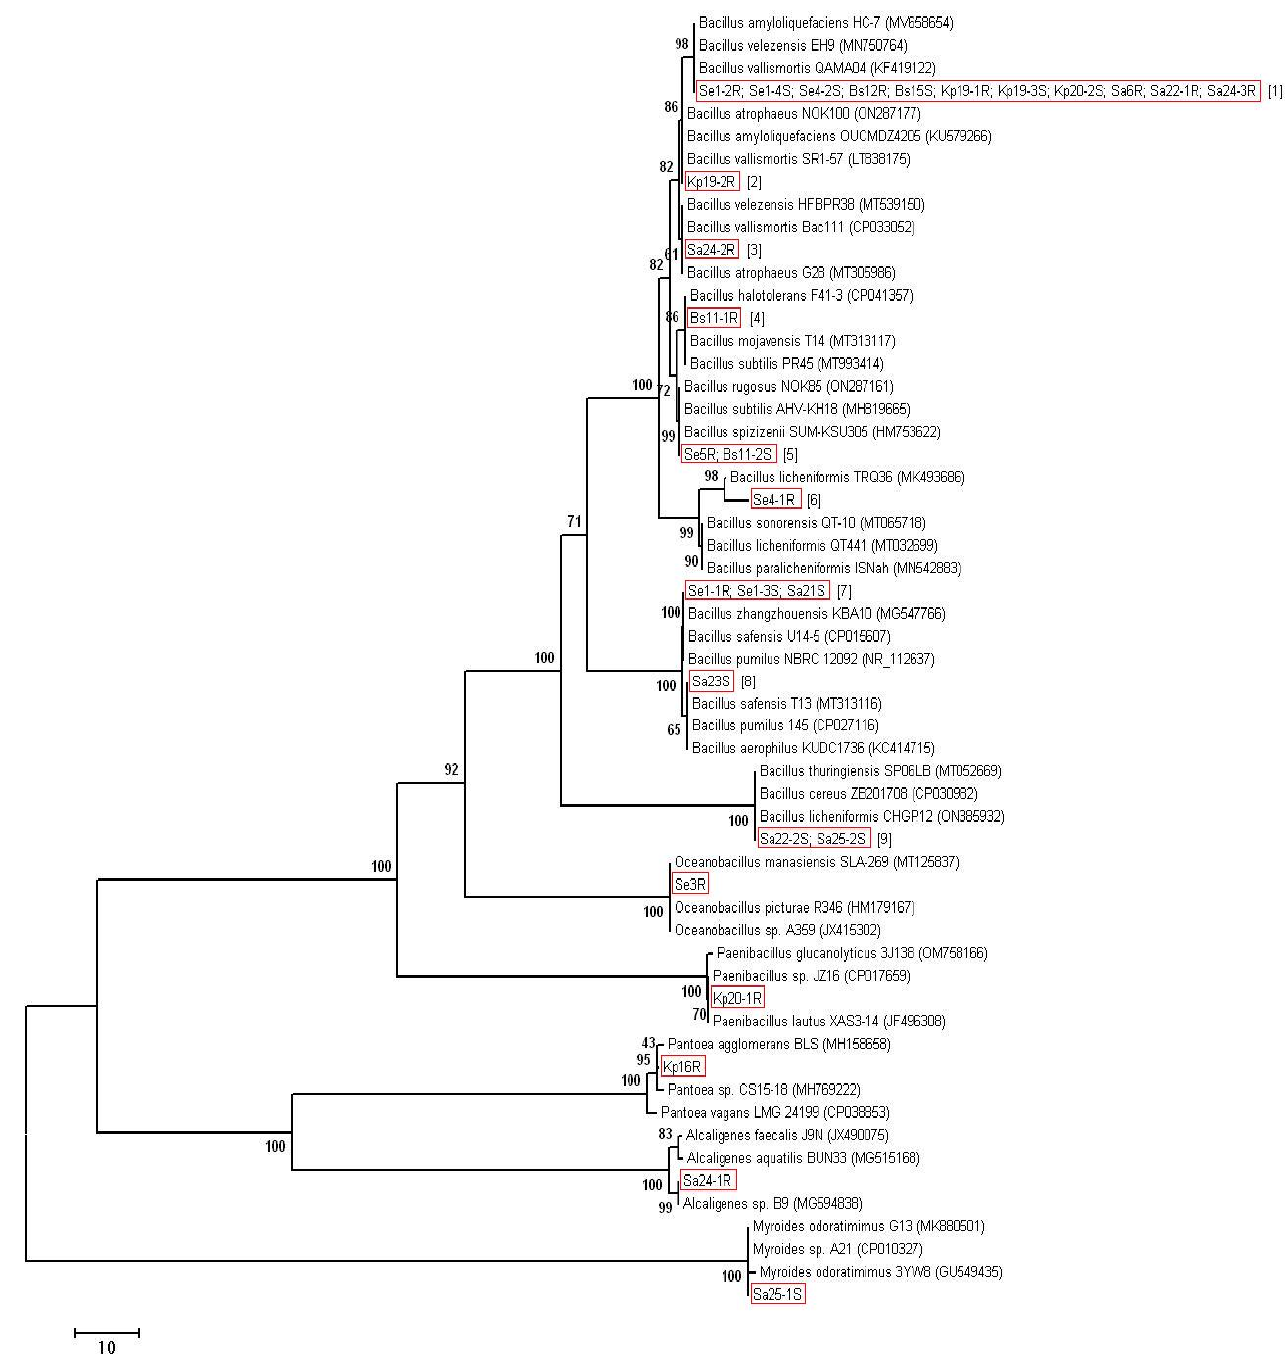
Figure 1. Phylogenetic analysis of 16S rRNA sequences of the bacterial isolates. The Neighbor-Joining clustering method with bootstrap value (500 replicates), pairwise deletion algorithm, and p-distance mathematical model were used. After the name of the isolates, the group number is indicated in square brackets.